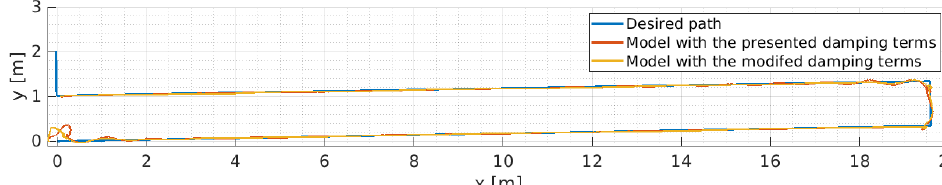
Figure 13. Simulation results for path following employing the modified controller with hydrody- namic damping terms multiplied by a factor of 2.